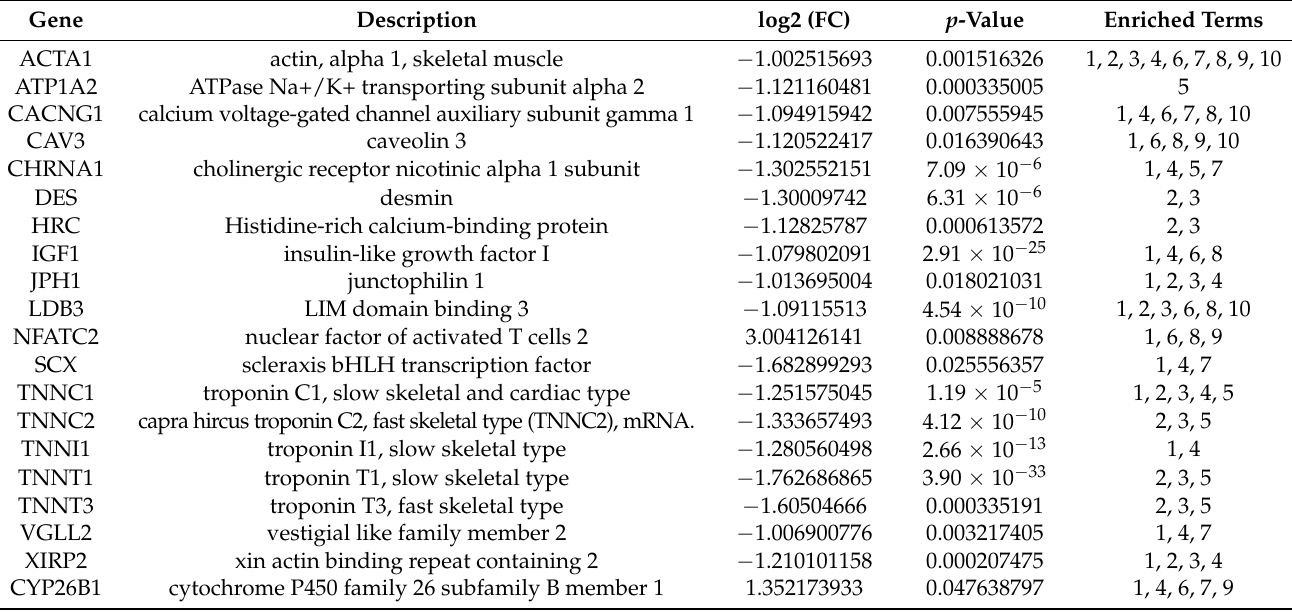
Table 2. Genes related to muscle development and affected by QKI